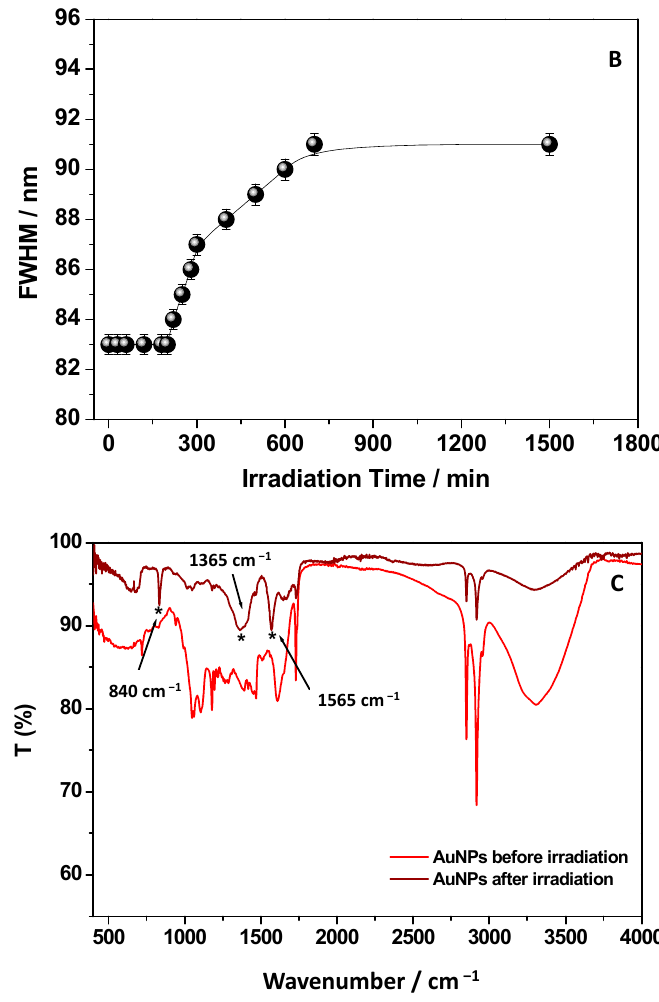
Figure 5. Effect of irradiation time, by using a sun simulator lamp, on wavelength position ( A ) and FWHM ( B ) of AuNPs SPR. The inset ( A ) shows the intensity of the SPR band in terms of absorbance values read at the maximum of SPR at several irradiation times. ATR-FTIR spectra of AuNPs before and at the end of irradiation. Bands indicated with * at 840, 1365, and 1565 cm − 1 suggest the formation of surface carbonates, and the finding agrees with the well-known mechanisms of phenol photodegradation ( C